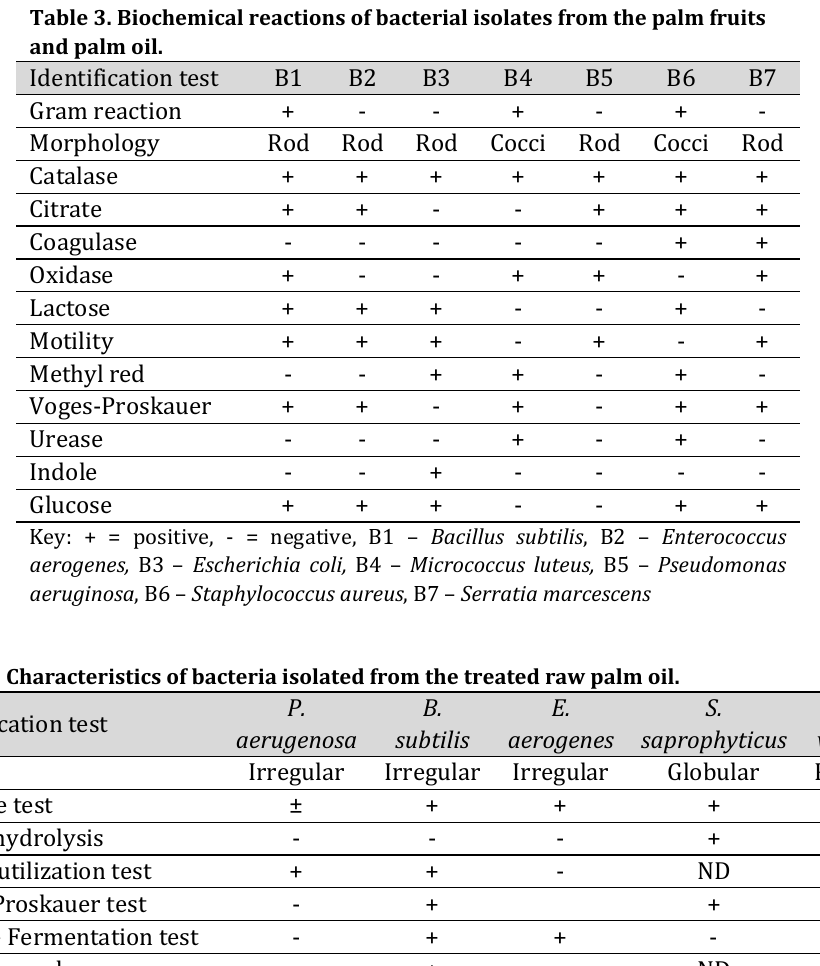
Table 3. Biochemical reactions of bacterial isolates from the palm fruits and palm oil.